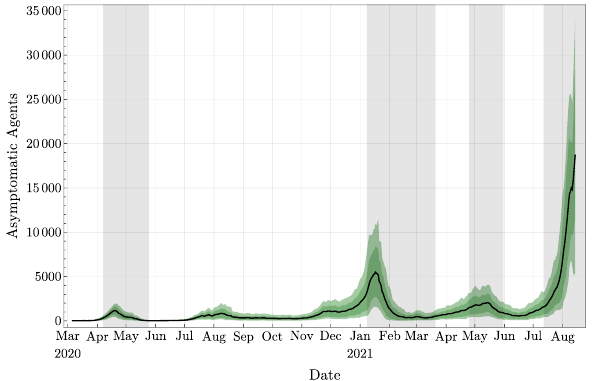
Figure 8. Estimated number of asymptomatic agents in I a , with 68% and 90% confidence intervals.